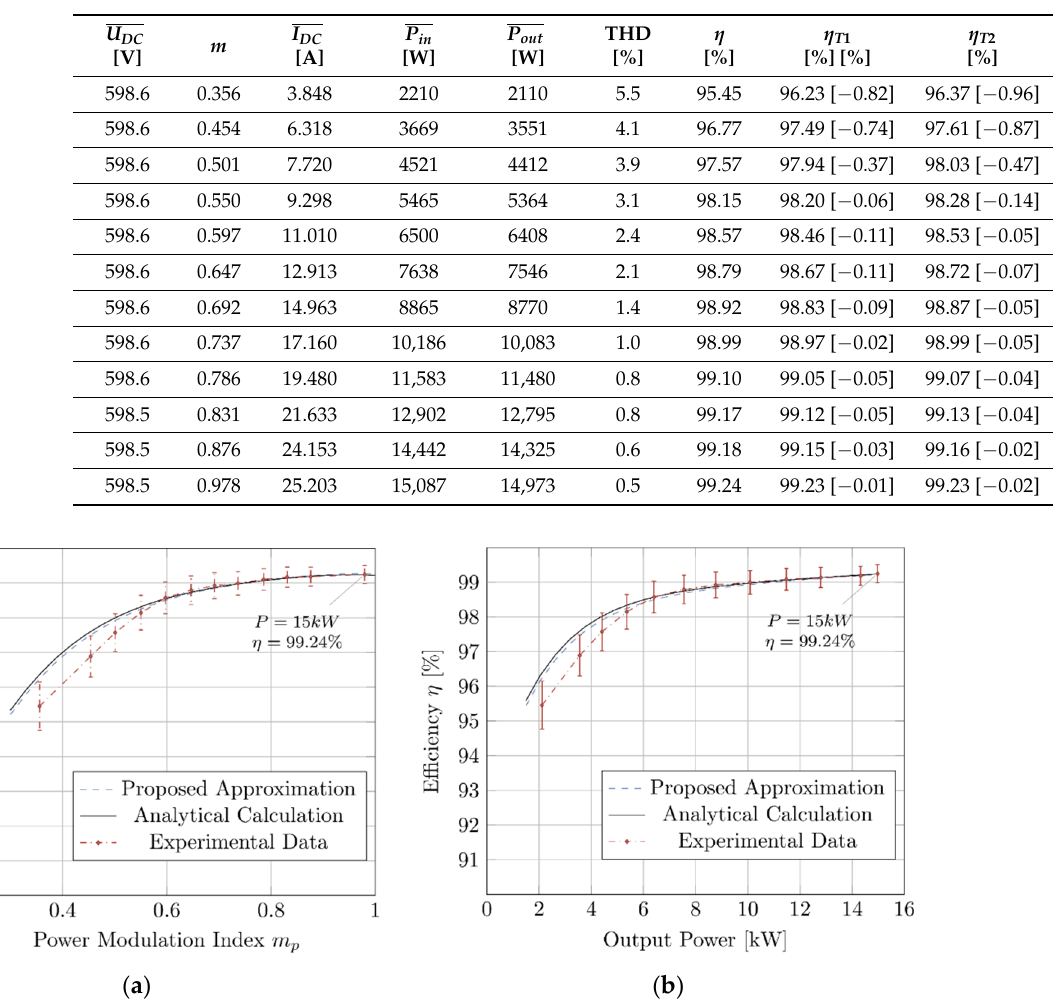
Figure 11. Analytical estimation of the separate contribution of conduction and switching losses for the total losses measured in the experimental setup.